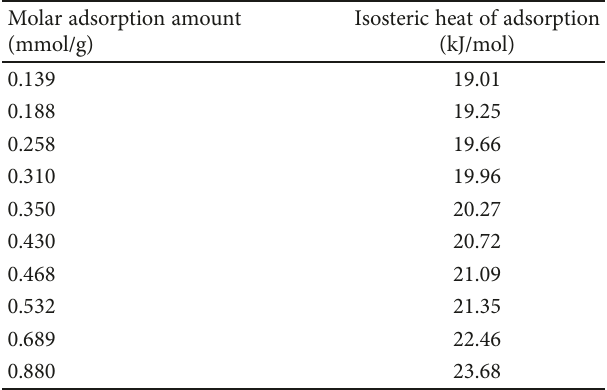
Table 4: Isosteric heat of adsorption obtained from measurement using C80 microcalorimeter.